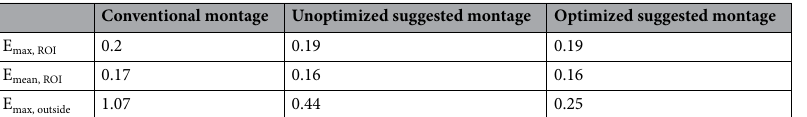
Table 2. Maximum and mean electric field in the retina for three different conditions: conventional montage and suggested montage with and without optimizing injection currents. E max, ROI , E mean, ROI , E max, outside represent the maximum electric field in ROI, mean electric field in ROI, and maximum electric field outside ROI, respectively. (Unit: V/m).